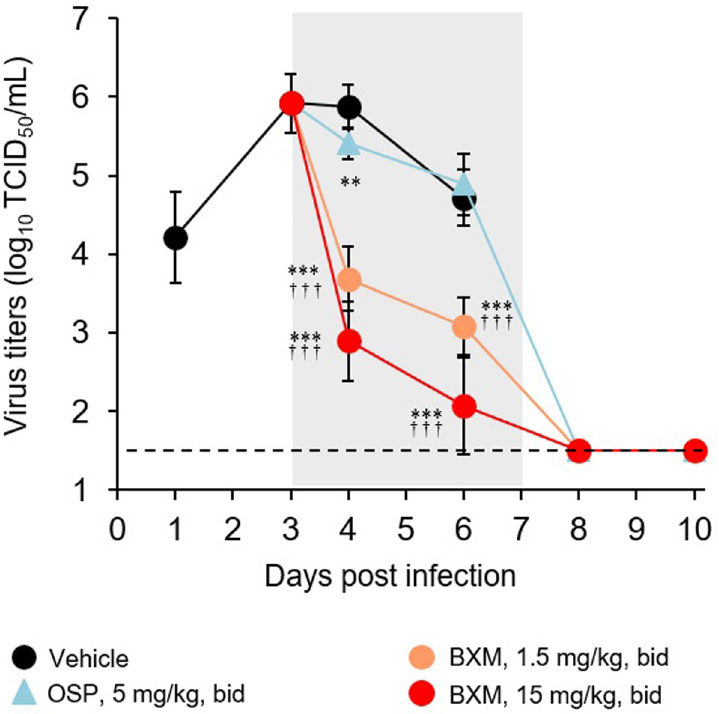
Fig 5. Inhibitory effects of delayed administration of BXM on virus replication in mice. Mice infected with A/PR/ 8/34 (1.38 × 10 3 TCID 50 ) were orally treated with BXM (1.5 or 15 mg/kg), OSP (5 mg/kg), or vehicle bid daily up to 5 days from 72 hours p.i. and were euthanized on the indicated days. Treatment period is indicated by the gray zone. Virus titers in the lungs were measured by the TCID 50 method. The limit of quantification (1.50 log 10 TCID 50 /mL) is indicated by a dotted line. Each point represents the mean ± SD of 6 to 8 mice except points that indicated virus titer on days 8 and 10 in mice treated with OSP (N = 1), in which only one mouse survived. Virus titers in mice treated with BXM and OSP on days 8 and 10 were at or lower than the quantification limit. Significant differences in virus titers were observed in BXM- and OSP-treated groups in comparison with the vehicle-treated group on the days 4 and 6, and day 4 p.i., respectively ( �� , P < 0.01; ��� , P < 0.0001). Significant differences in virus titers were also observed between BXM- and OSP-treated groups on days 4 and 6 p.i. ( ††† , P <